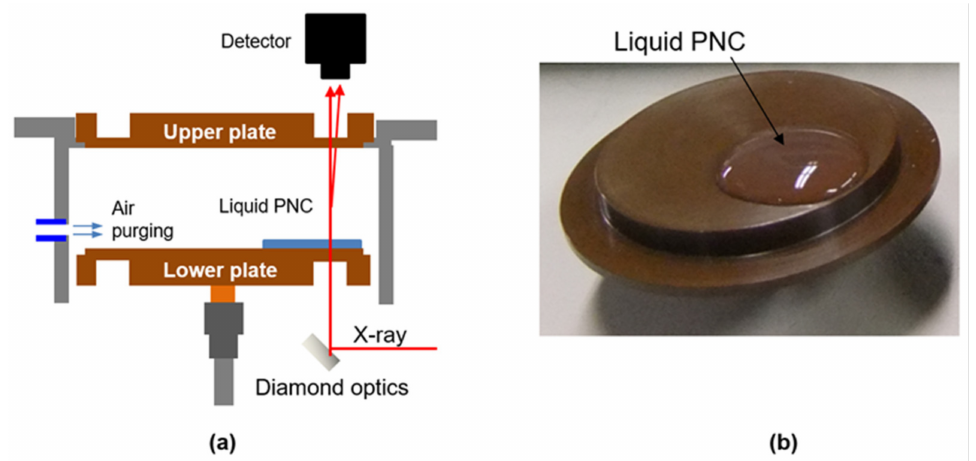
Figure 1. ( a ) Schematics of drying experiment with vertical -SAXS. ( b ) Silica-PVA PNC solution loaded onto lower